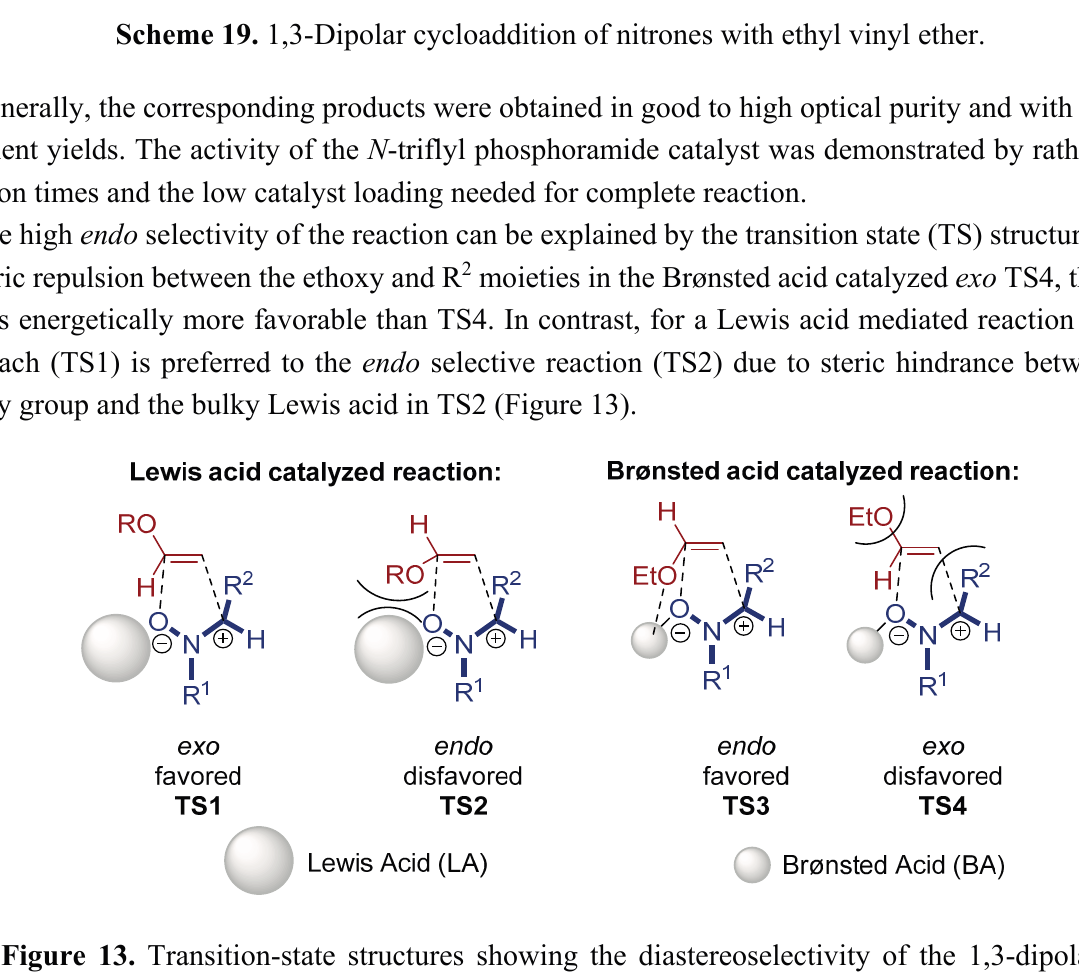
Figure 13. Transition-state structures showing the diastereoselectivity of the 1,3-dipolar cycloaddition of nitrones catalyzed by LA and